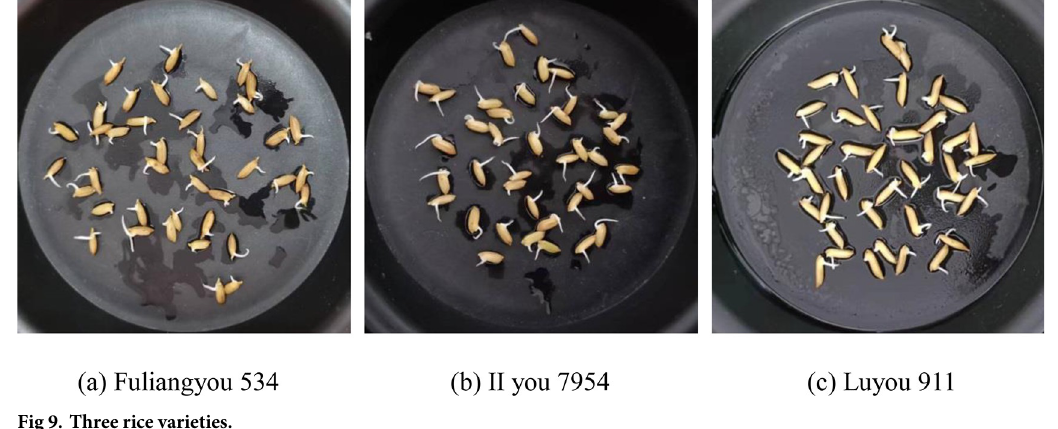
Fig 9. Three rice